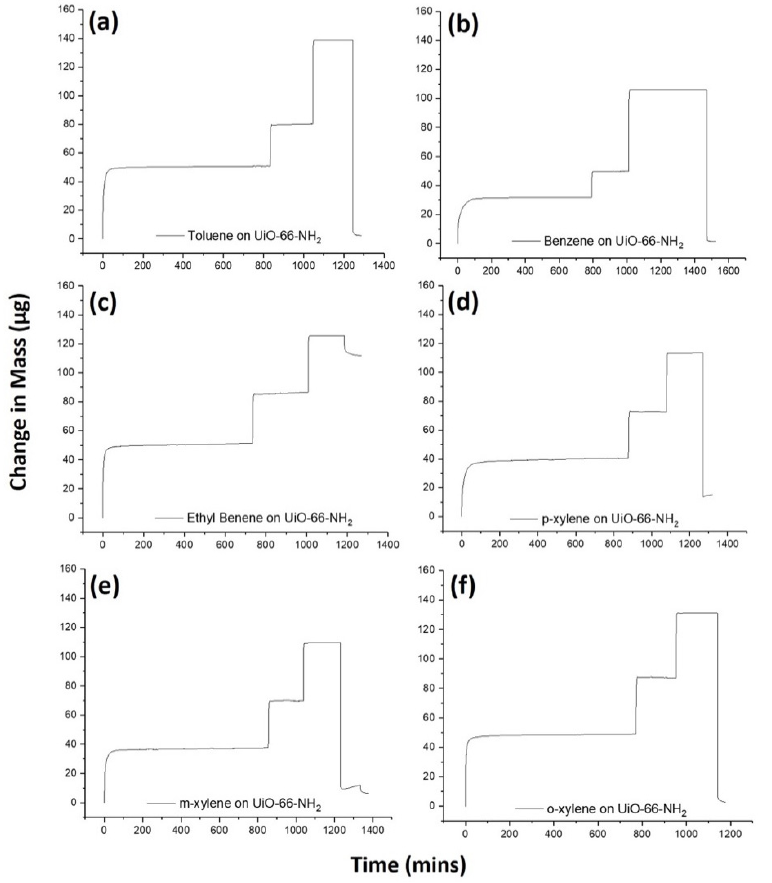
Figure 6. Representative QCM data for adsorption experiments of ( a ) benzene, ( b ) toluene, ( c ) ethylbenzene, ( d ) p -xylene, ( e ) m -xylene, and ( f ) o -xylene on a UiO-66-NH 2 film.